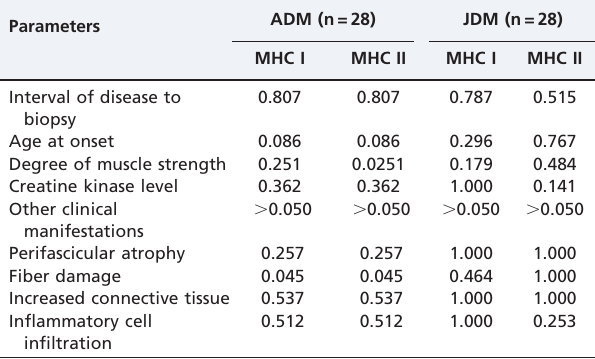
Table 3 - Relationship among various myositis parameters and the MHC I / II presence in